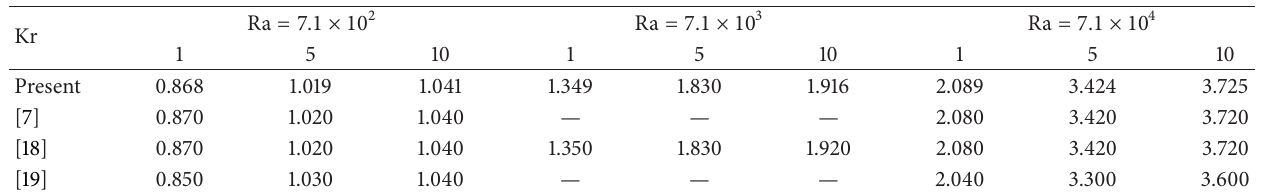
Table 1: Comparison of the average Nusselt number between the present results and other works for various Rayleigh numbers and wall-to- fluid thermal conductivity ratios.